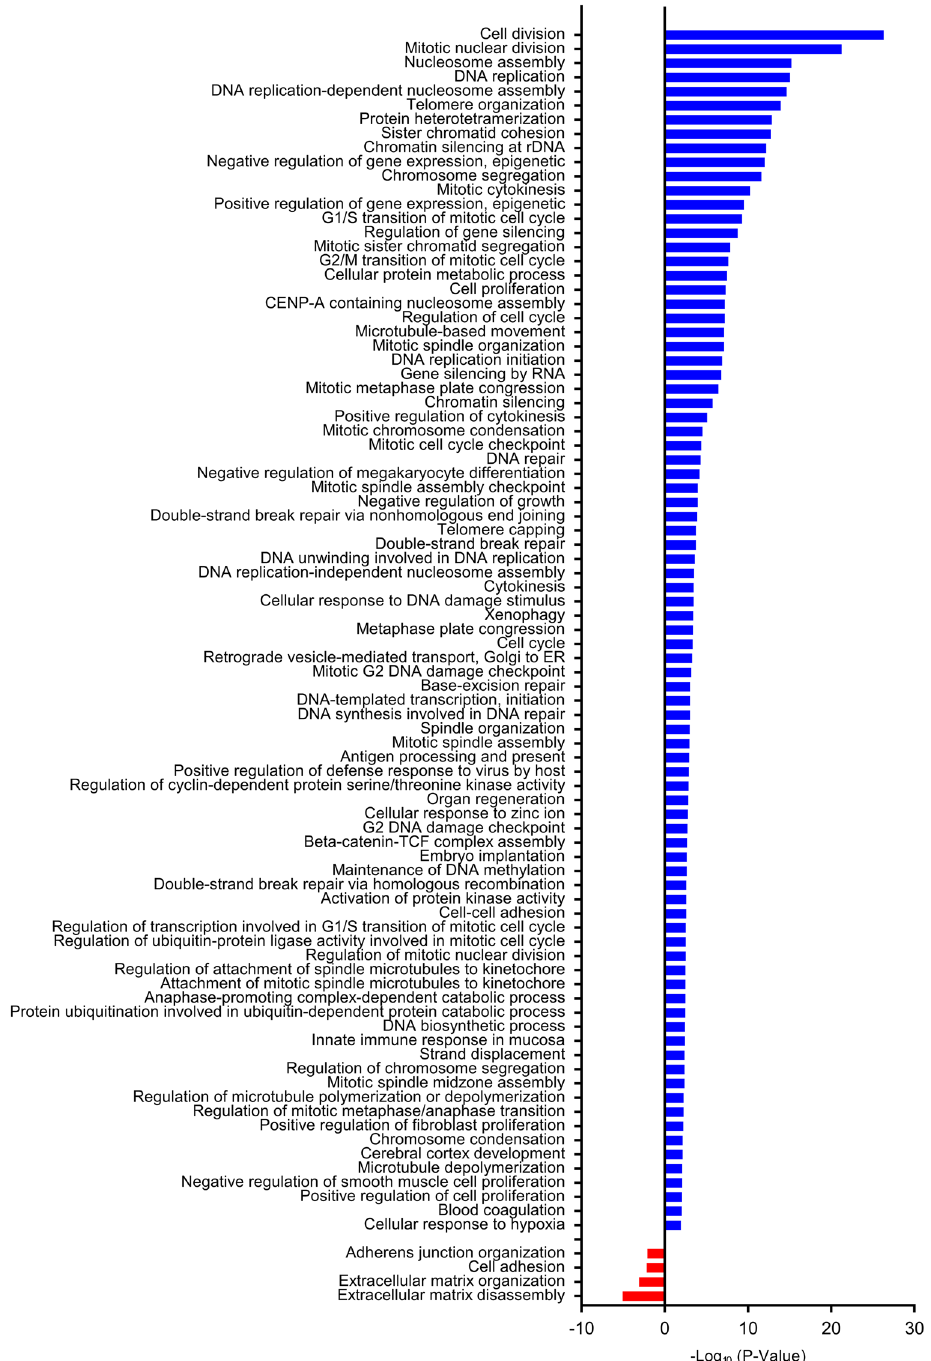
Fig. 4 Enrichment analyses of Gene Ontology terms in cultured STAG2 Ser327Asn fi broblast. Bar plots represent the statistical signi fi cance of the enrichment ( − log 10 ( p -value)) in STAG2 Ser327Asn fi broblasts. Expression of genes in cell division, mitosis, DNA replication, and DNA damage repair pathways, shown in blue bars , was upregulated in the STAG2 Ser327Asn fi